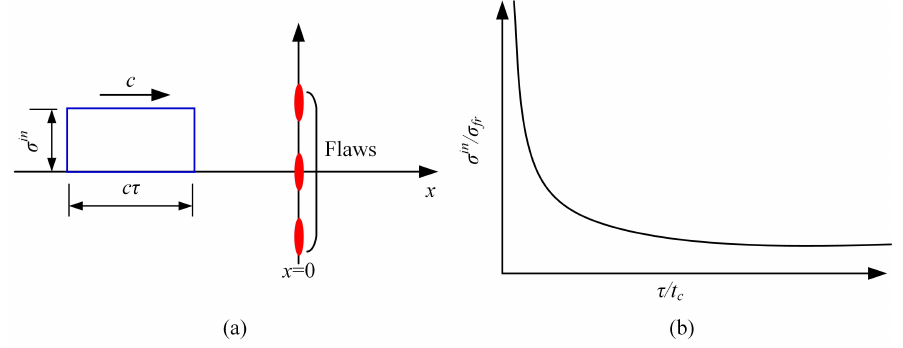
Figure 22. ( a ) The configuration for determining fracture time dependence. ( b ) time dependence of the incident stress σ in to cause